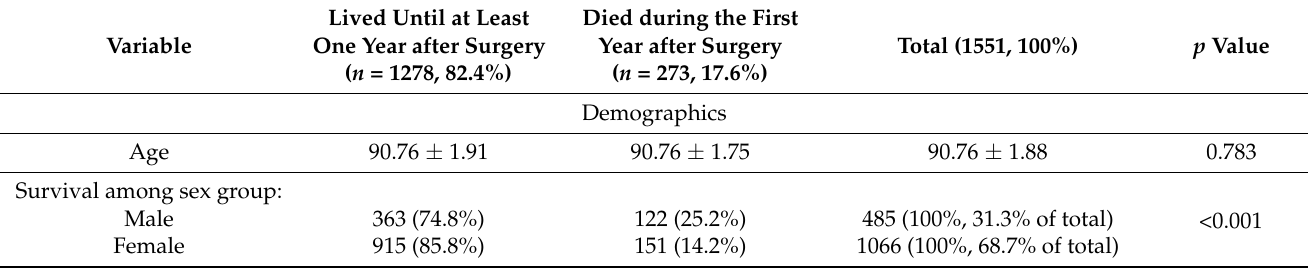
Table 2. Patients who underwent surgery for a proximal femur fracture. Categorical variables are presented as absolute counts with rates, and continuous variables are presented as mean ± standard deviation. CHF, chronic heart failure; CRF, chronic renal failure; DM, diabetes mellitus; COPD, chronic obstructive pulmonary disease; HTN, hypertension; IHD, ischemic heart disease; AF, atrial fibrillation; PAF, paroxysmal atrial fibrillation; CRIF, closed reduction internal fixation; THA, total hip arthroplasty; HA, hemi arthroplasty; MCV, mean corpuscle volume; RDW, red blood cell distribution; MPV, mean platelet